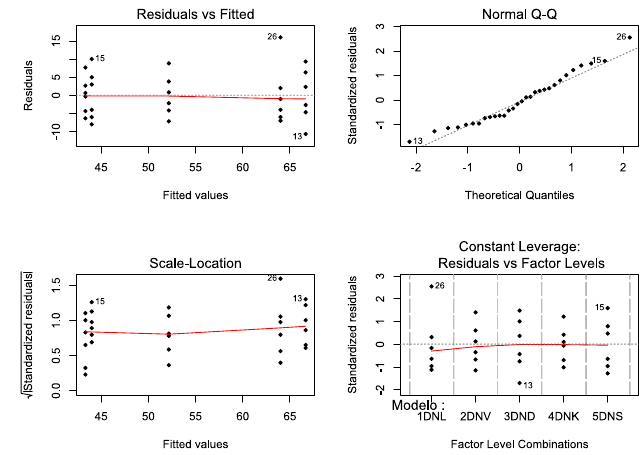
Figure 6. Graphical analysis of the lifetime vs.